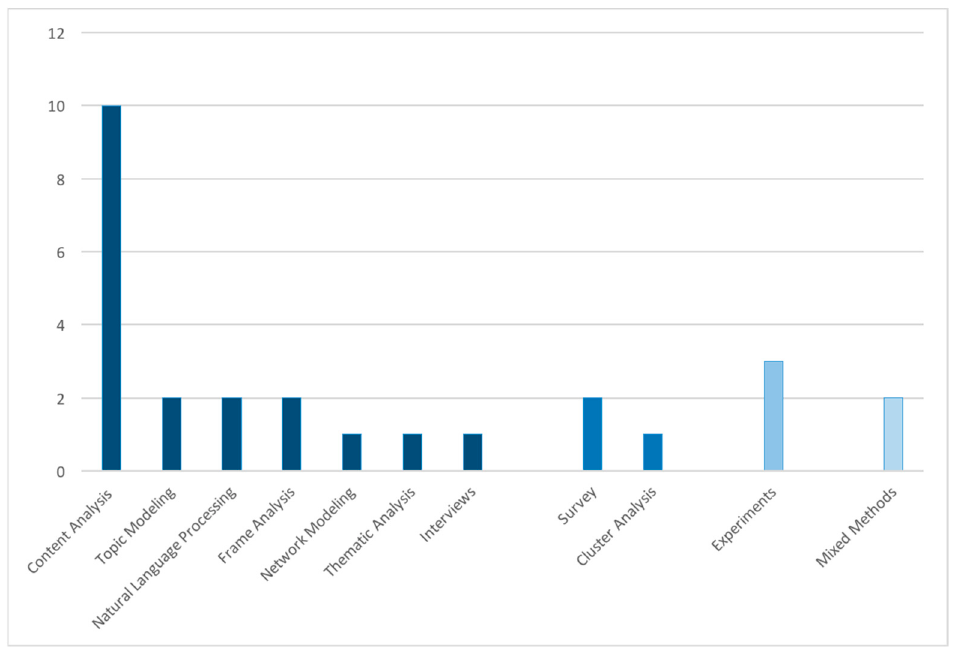
Figure 4. Analytical methods used: Qualitative (darkest blue), quantitative (blue), experimental (light blue) and mixed methods (lightest blue).